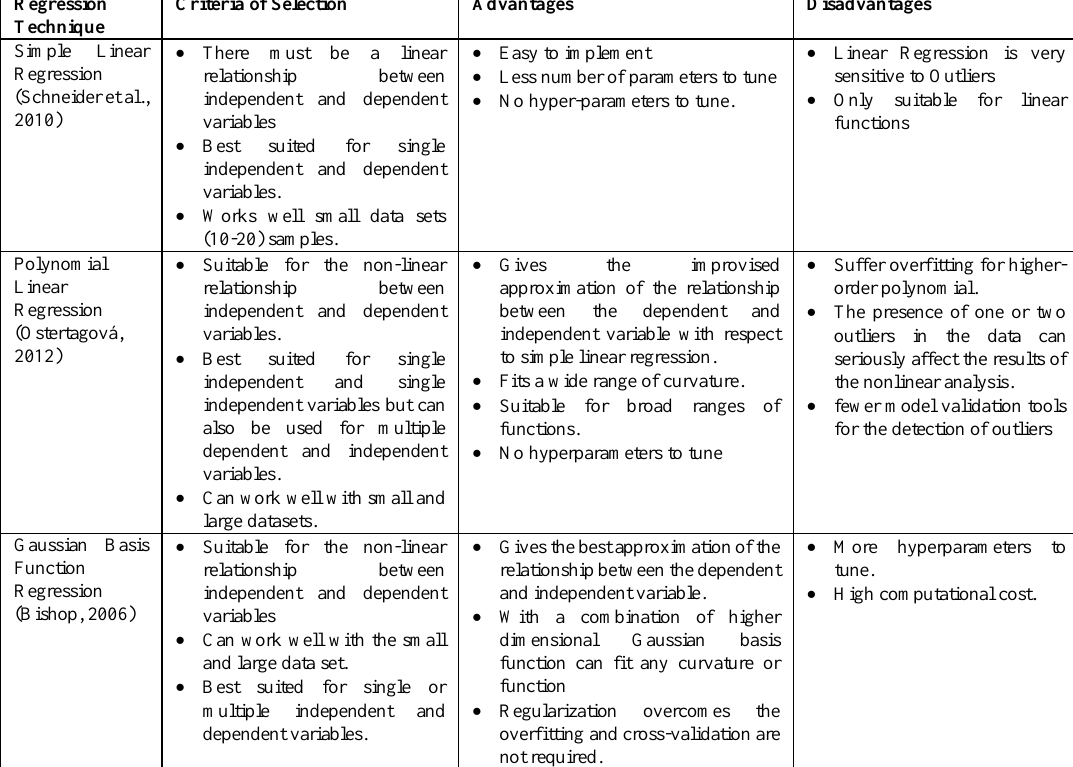
Table 1. Comparison of different linear regression